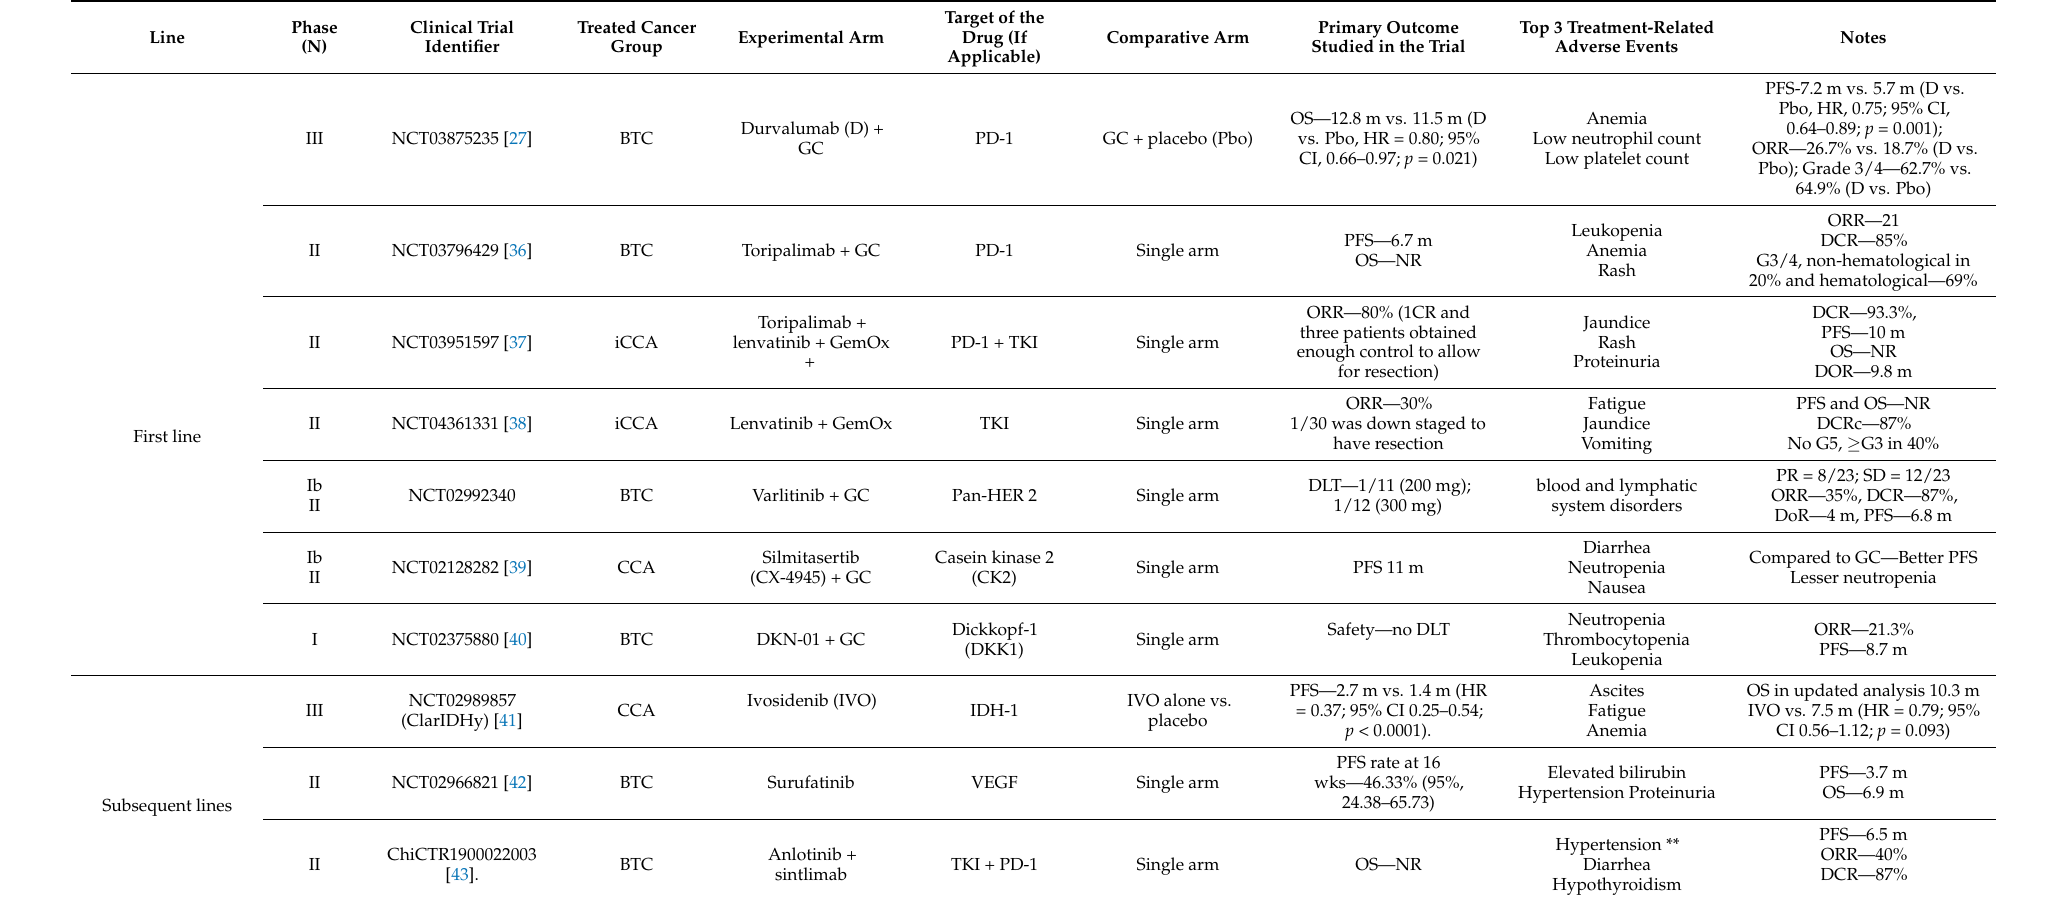
Table 2. Results of recent trials in biliary tract